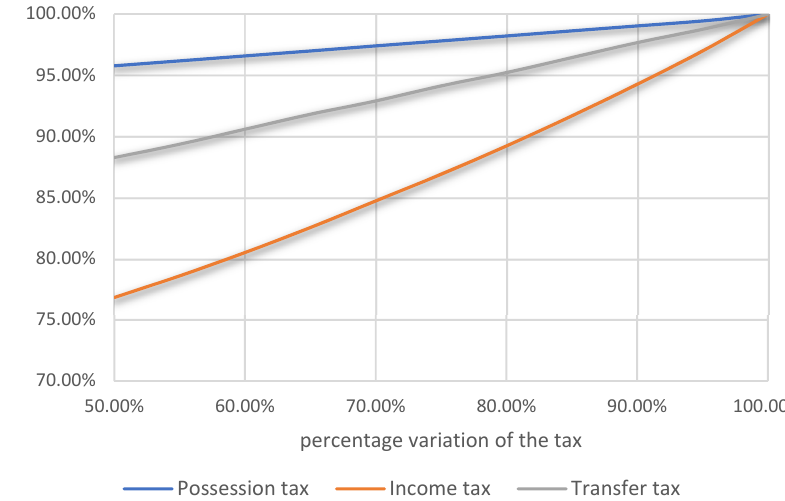
Figure 8. Change in the Pmt for changes in the individual tax items.